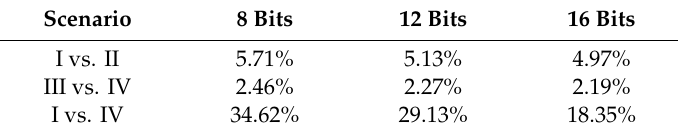
Table 3. System throughput improvement in di ff erent